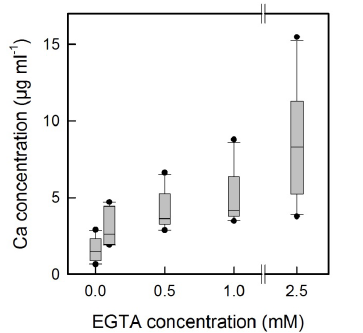
Fig. 8: Effect of EGTA concentration on stiffness (S) (a, b), maximum force (F max ) (c, d) and maximum strain ( ε max ) (e, f) of internodes (a, c, e) and nodes (b, d, f) of Chara corallina taken from positions 2 and 3 along the stem. Means followed by the same letter do not differ sig - nificantly, P <